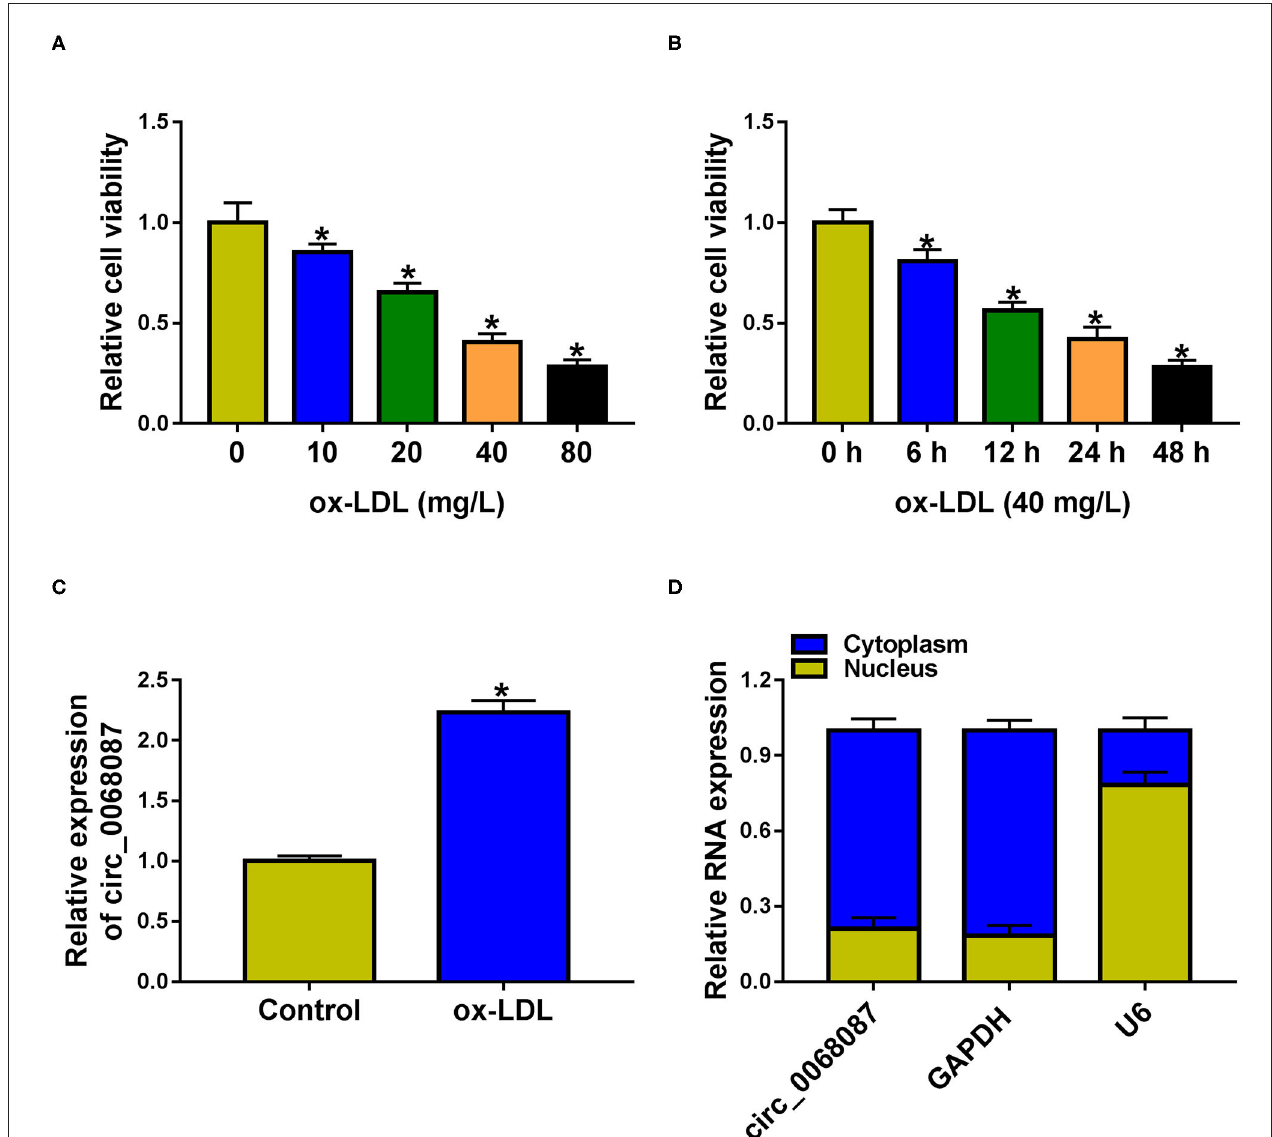
FIGURE 1 | Circ_0068087 is upregulated by ox-LDL in HUVECs. (A) Cell viability in HUVECs exposed to different doses of ox-LDL (10, 20, 40, and 80 mg/L) for 24h was determined by MTT assay. This experiment was performed three times with five technical repetitions each time. One-way ANOVA followed by Tukey’s post hoc test was used to assess the differences. (B) MTT assay was utilized to analyze cell viability of HUVECs stimulated by 40 mg/L ox-LDL for 6, 12, 24, or 48h. This experiment was performed three times with five technical repetitions each time. One-way ANOVA followed by Tukey’s post hoc test was used to assess the differences. (C) The expression of circ_0068087 was examined in HUVECs treated with or without 40 mg/L ox-LDL for 24h by RT-qPCR. This experiment was performed three times with three technical repetitions each time. An unpaired Student t -test was used to evaluate the differences. (D) The subcellular location